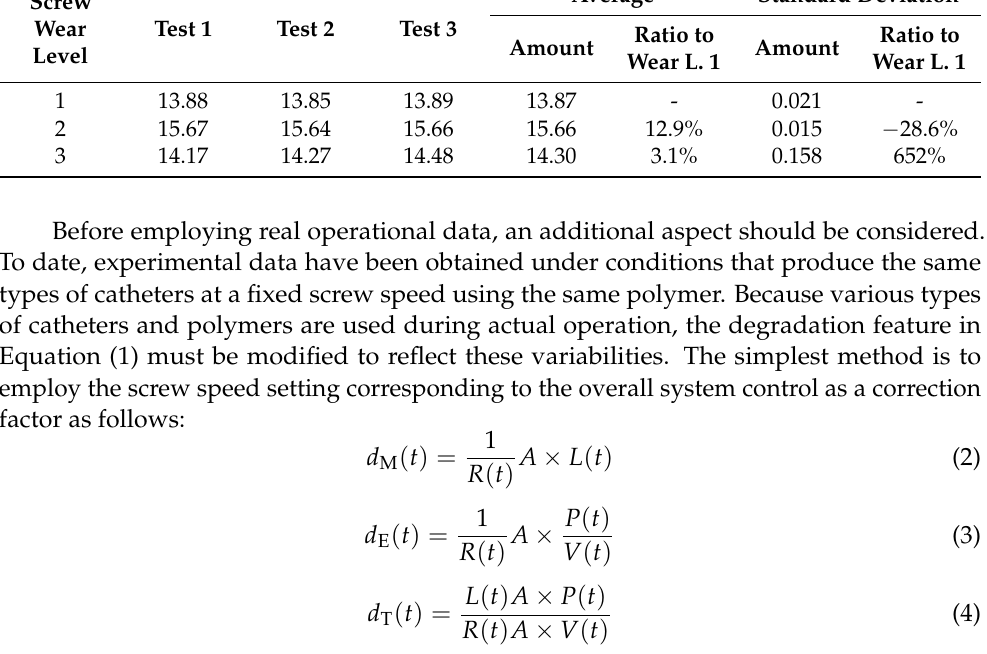
Wear level (yr.) Figure 10. Degradation feature analysis; the material and product were kept the same.